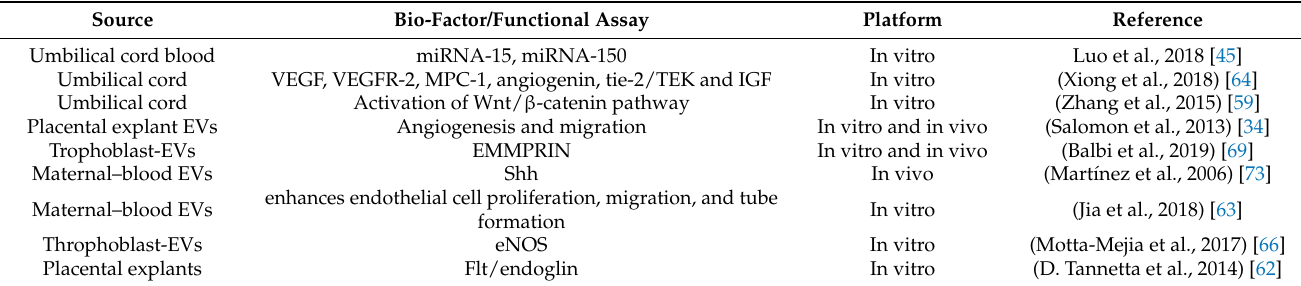
Table 1. Angiogenic factors associated with EVs and their role in